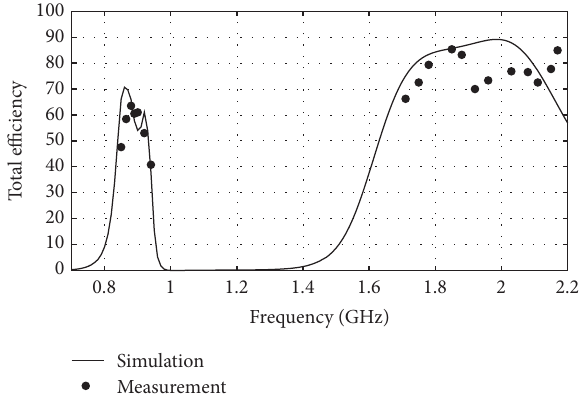
Figure 7: Simulated and measured VSWR of dual ZOR antenna with BSF.